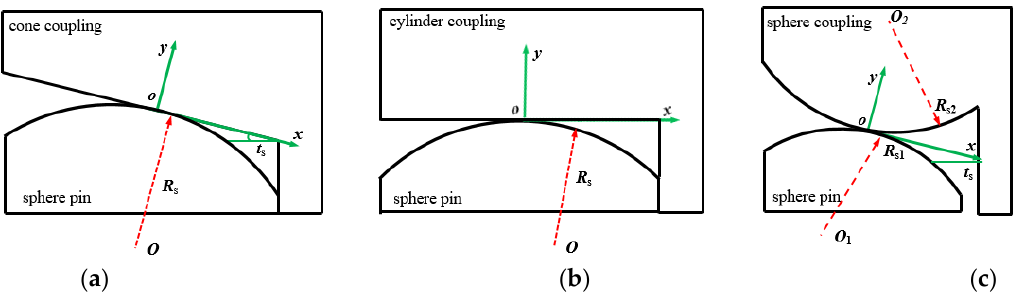
Figure 2. Metal-to-metal seal structures of a sphere-type premium connection, the sphere-to-cone type is for ( a ), the sphere-to-cylinder type is for ( b ) and the sphere-to-sphere is for ( c